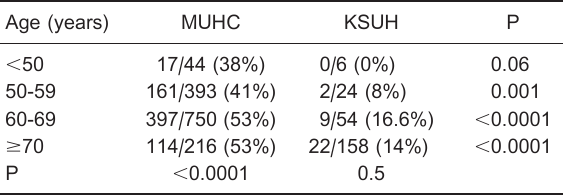
Table 3. Age-associated prevalence of prostate cancer in the MUHC and KSUH